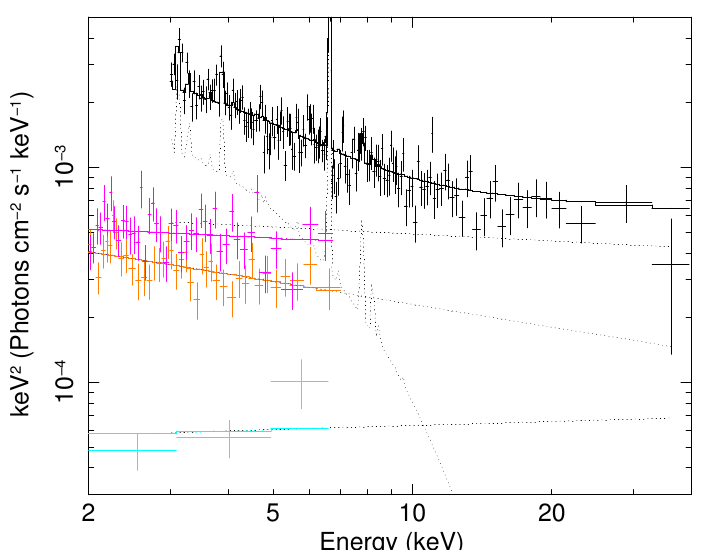
Figure 2. NuSTAR spectrum (black) joint-fitted with the Chandra spectra (color). The core (magenta; upper), jet (orange; middle), and HST -1 (cyan; lower) components joint-fitted to the Chandra spectra are shown. The three power-law, straight dotted lines are models for these three components best-fitted to the NuSTAR data. The dotted curve is the ICM component. The solid line is the total spectral model. This figure is reproduced from Wong et al.